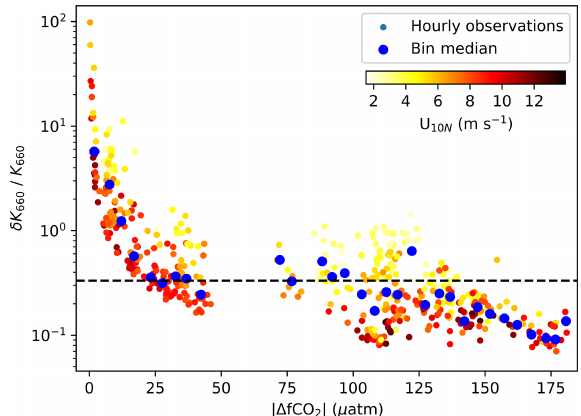
Figure 10. Relative uncertainty in EC-estimated hourly K 660 ( δK 660 /K 660 ) vs. the magnitude of the air–sea CO 2 fugacity differ- ence ( | (cid:49)f CO 2 | ) during Arctic cruise JR18007 and Atlantic cruises AMT28 and AMT29 (no (cid:49)f CO 2 data were collected on JR18006). The data points are colour-coded by wind speed. Blue points are medians of δK 660 /K 660 in 5µatm bins. Here we use the param- + 2.46) to normalise the uncertainty eterised K 660 ( = 0.22 U 2 10N in K 660 . The dashed line represents the 3 : 1 signal : noise ratio ( δK 660 /K 660 = 1 / 3 )